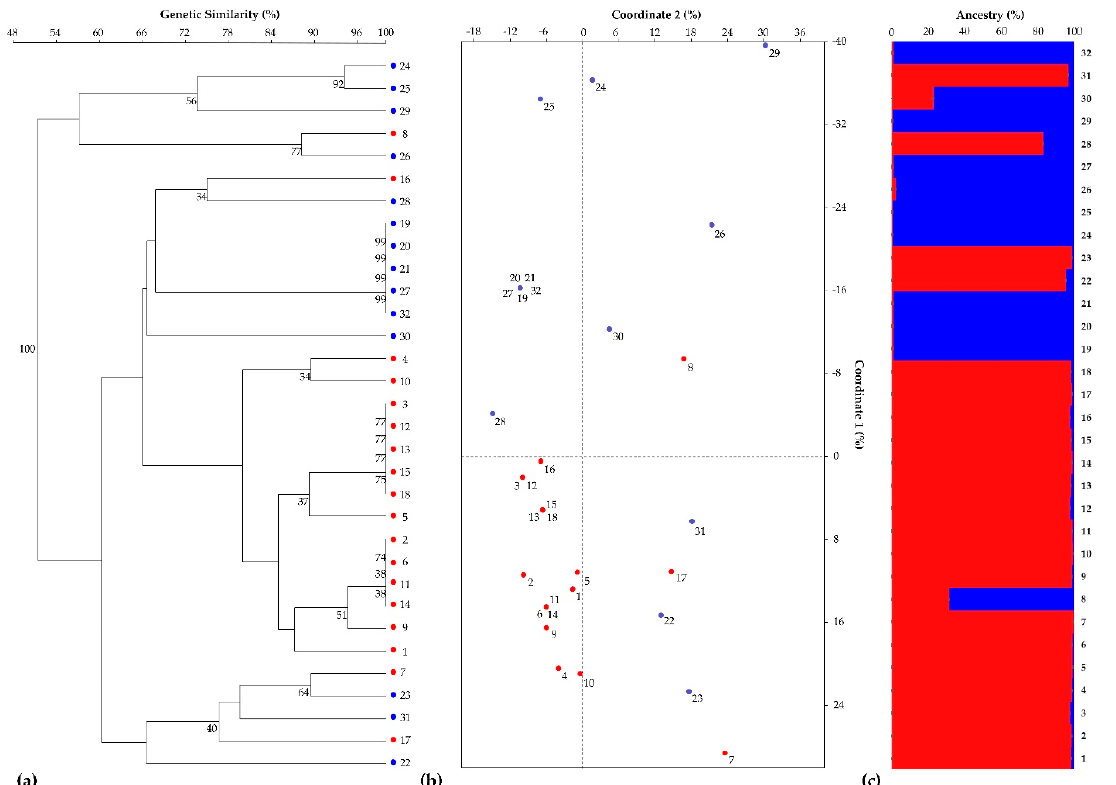
Figure 1. Grouping analysis of 32 accessions of endive based on 14 SSR markers. ( a ) UPGMA dendrogram of genetic similarity estimates computed among pairwise comparisons of individual samples using Jaccard’s coe ffi cient. Bootstrap estimates ≥ 30% are reported next to the nodes (red and blue dots highlight the two endive cultivar types, C. endivia var. latifolium and C. endivia var. crispum ). ( b ) Principal coordinate analysis (PCoA) centroids derived from the analysis of genetic similarity estimated with Jaccard’s coe ffi cient (red and blue dots correspond to the individual samples of the two cultivar types, C. endivia var. latifolium and C. endivia var. crispum ). ( c ) Population genetic structure of the 32 endive samples as estimated by STRUCTURE. Each sample is represented by a vertical histogram partitioned into K = 2 colored segments (red or blue, corresponding to ( a ) and ( b )) representing the estimated membership. The proportion of ancestry (%) is reported on the ordinate axis, and the identification number of each accession is reported below each